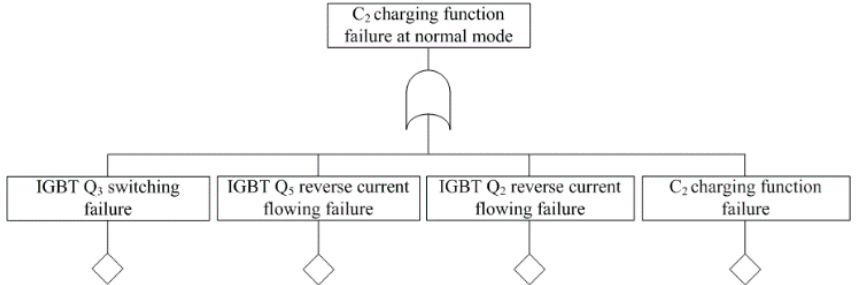
Figure 7. Sub fault tree for C 2 charging function failure at normal mode.